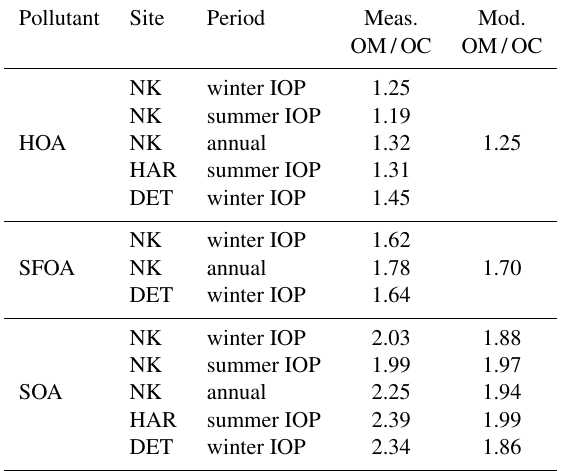
Table 5. Measured and modelled (addDiesel experiment) OM/OC ratios. Site name abbreviations are given in Table